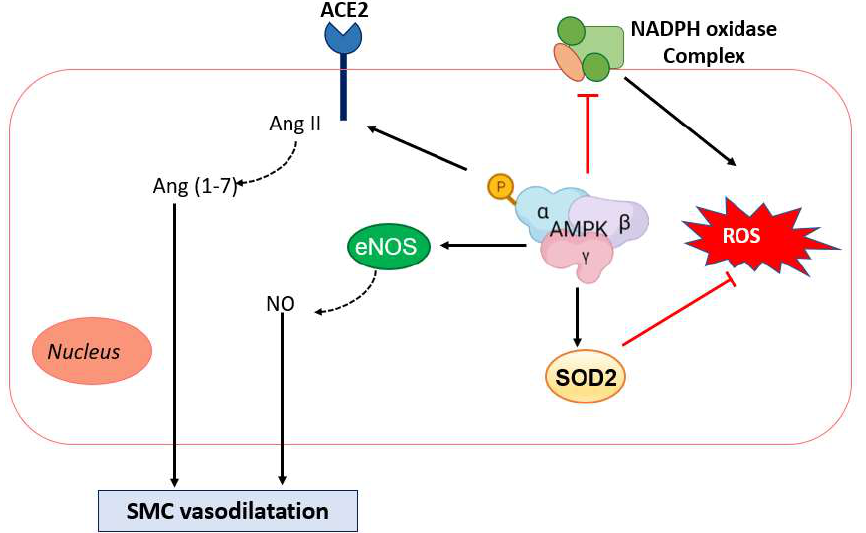
Figure 2. Role of AMPK in PAECs implicated in